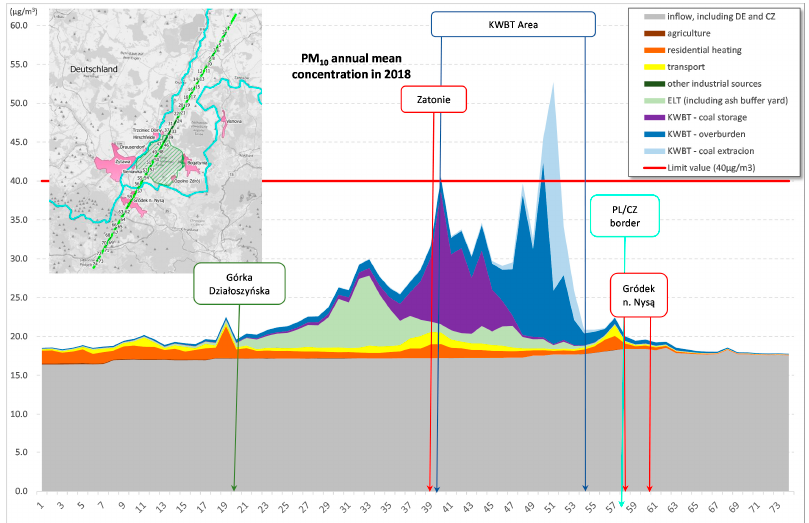
Figure 17. Profile of annual mean concentrations of PM 10 between Dzia ł oszyn and Hrádek nad Nisou, considering the shares of individual source groups in 2018 (source: own study).